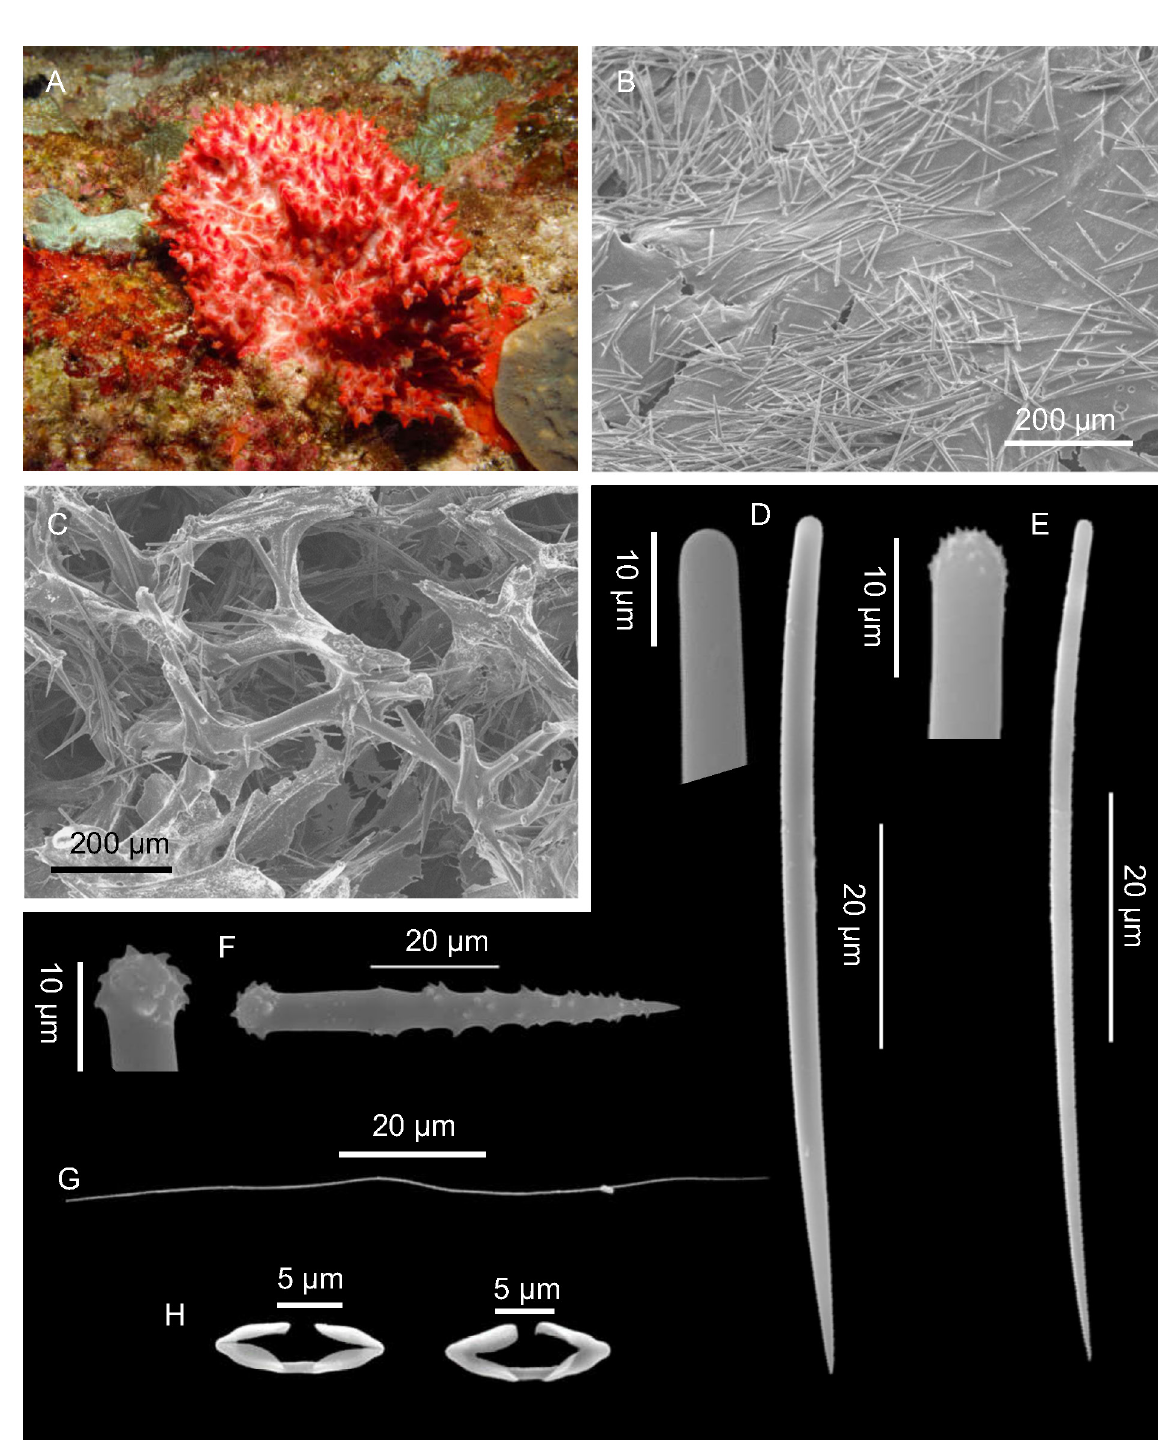
Fig. 22. Clathria ( Thalysias ) vulpina (Lamarck, 1814). A . Specimen IMG0826 in situ . B . Ectosomal skeleton (SEM). C . Choanosomal skeleton (SEM). D . Slightly curved style and magnification of its smooth head. E . Longer style and magnification of its microspined head. F . Acanthostyle and magnification of its microspined head. G . Very thin toxa. H . Palmate